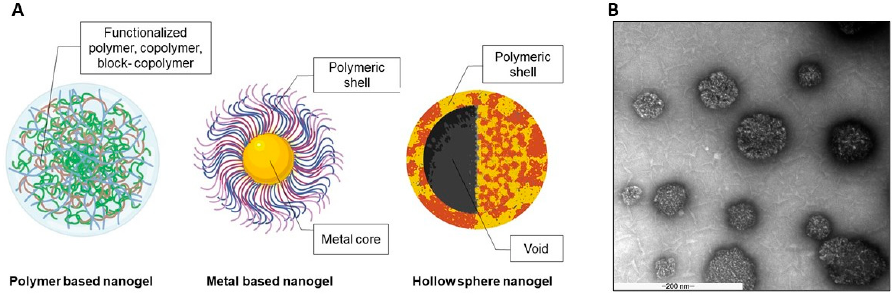
Figure 1. ( A ) Core-shell structures of nanogels ( B ) TEM image of hyaluronic acid-based polymeric nanogels (unpublished data).